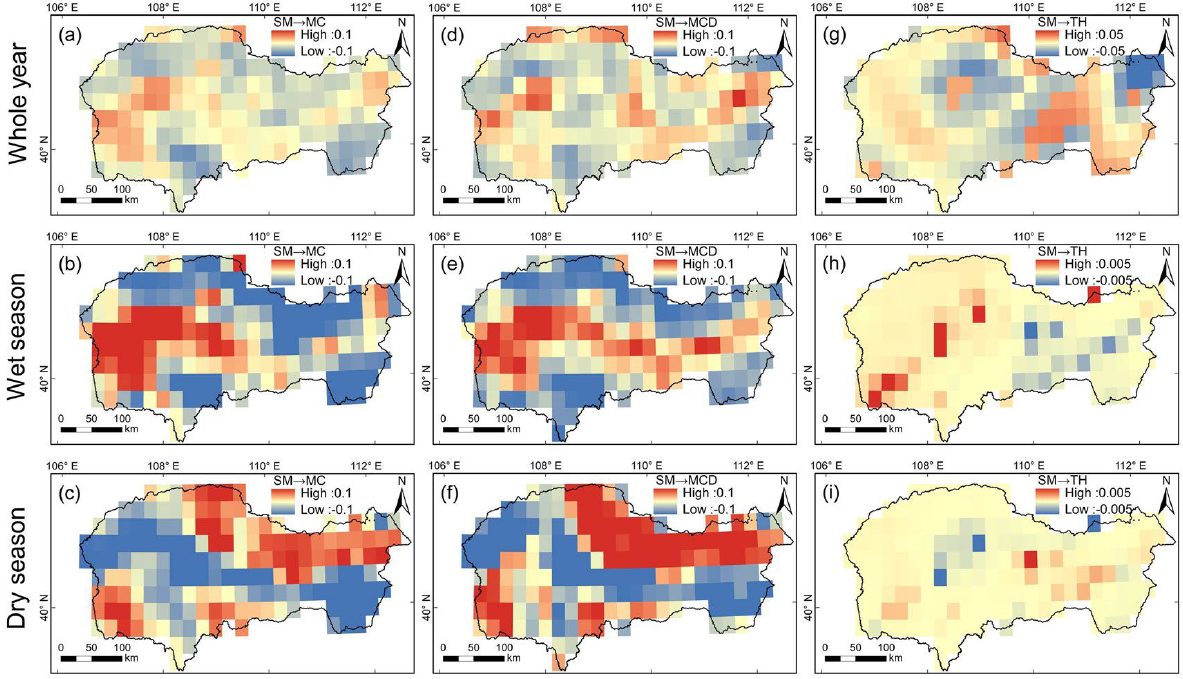
Figure 6. Soil moisture effects on the mean flow convergence and the two components of the mean flow convergence in the wet ( b , e , h ), dry seasons ( c , f , i ), and the whole year ( a , d , g ). ( a – i ), sensitivity coefficients for SM → moisture convergence (MC) ( a – c ), SM → mean circulation dynamic component (MCD) ( d – f ), SM → thermodynamic component (TH) ( g – i ).